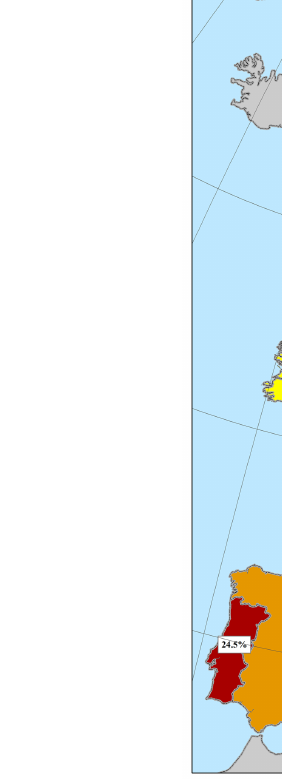
land marginality (1.03 Mha). In the case of missing values